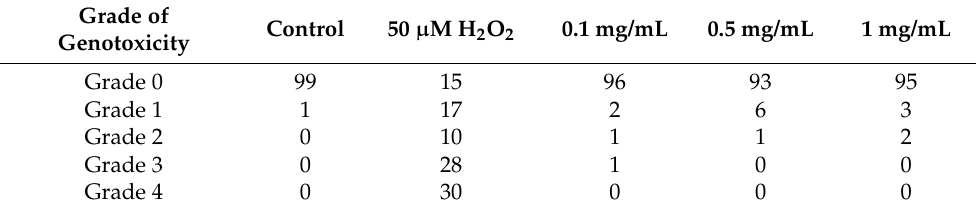
Table 4. Effect of PEG-GMO10 formulation on DNA damage in HaCaT cells estimated with the comet assay.